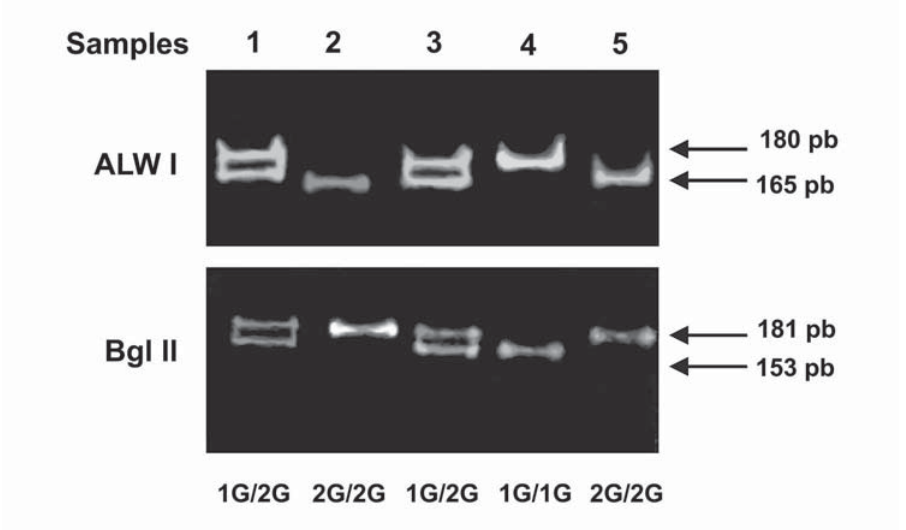
Figure 1 – RFLP analyses of MMP-1 promoter polymorphism. ALWI digests the 181 bp 2G amplicon (166 bp + 15 bp), leaving the 1G amplicon (180 pb) intact. Bgl II digests the 180 pb 1G (153 bp + 27 bp), leaving the 2G amplicon (181 bp) intact. Samples 1 and 3 are 1G/ 2G heterozygotes. Samples 2 and 5 are 2G/2G homozygotes. Sample 4 is 1G/1G